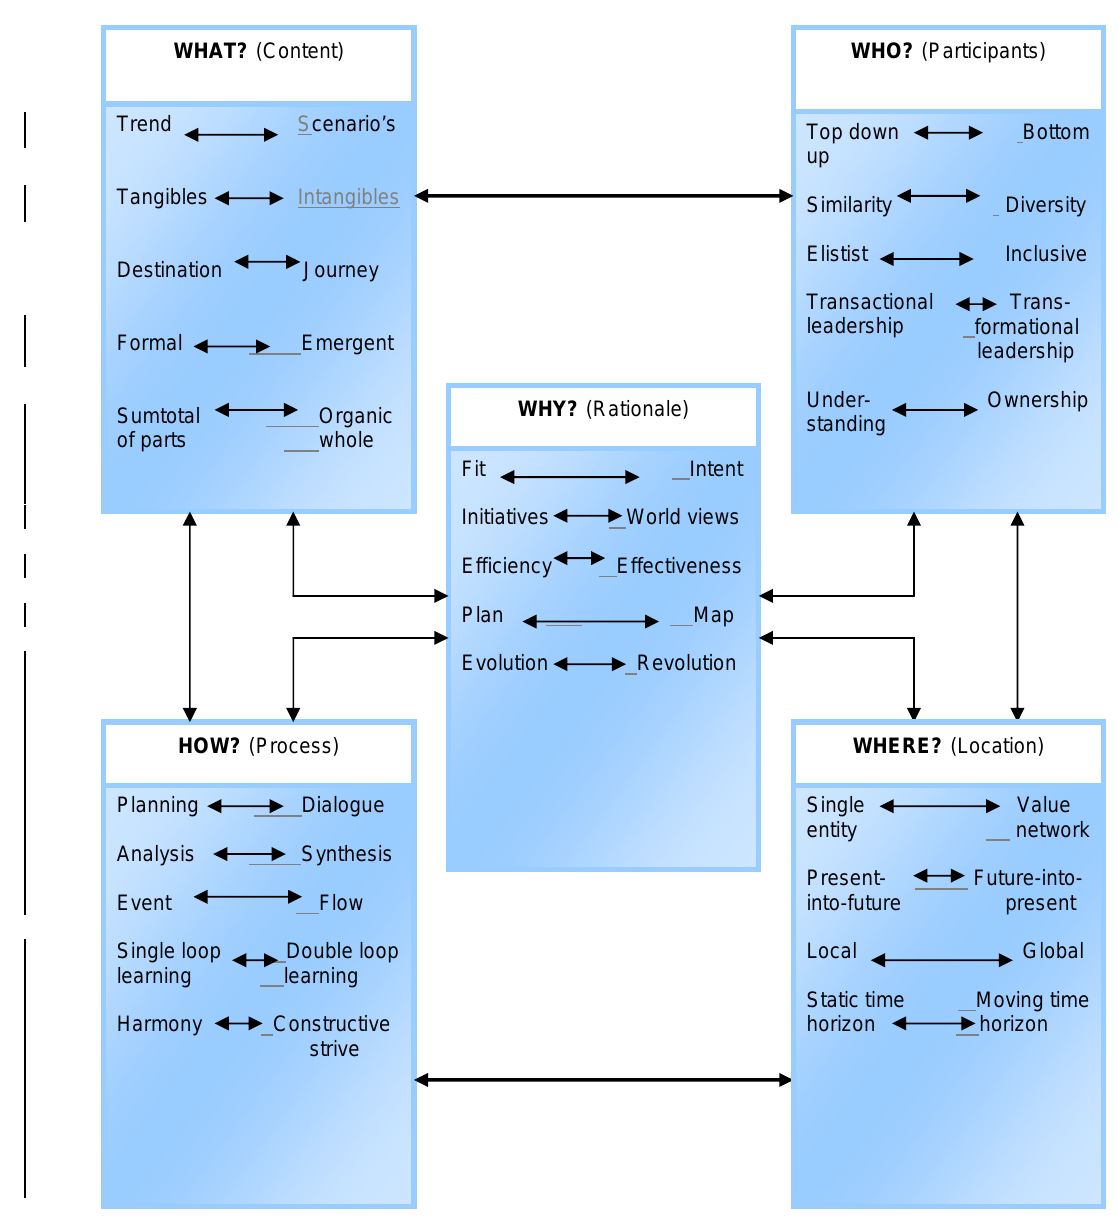
Figure 2: Strategising logic